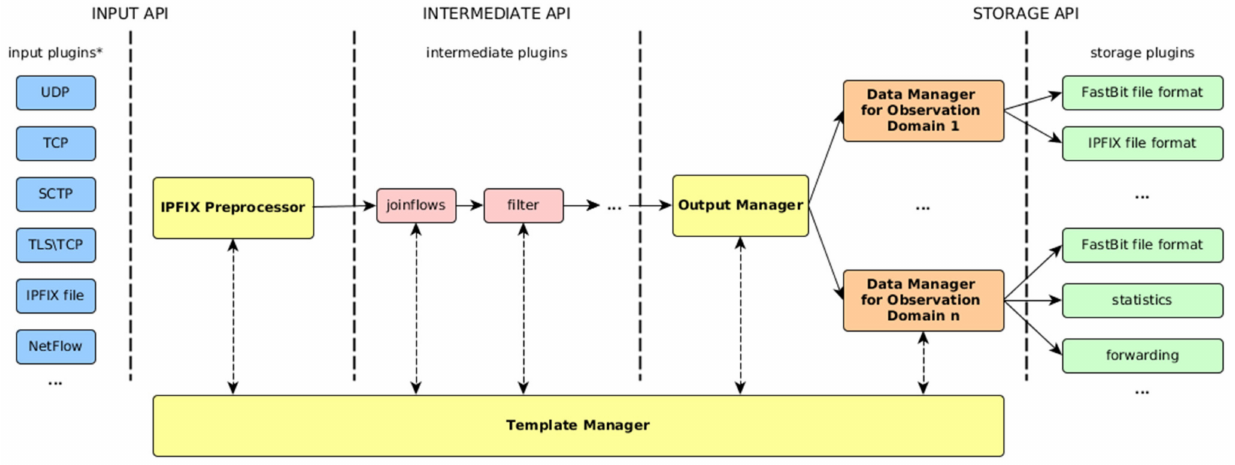
Figure 5. The IPFIXcol Architecture (https://github.com/CSIRT-MU/Stream4Flow, accessed on 13 January 2023). * Select one for IPFIX Preprocessor.